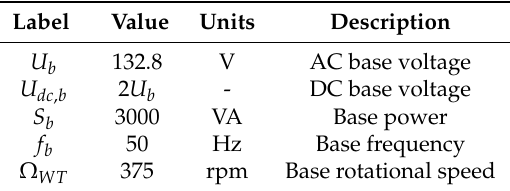
Table 1. Base values for per unit